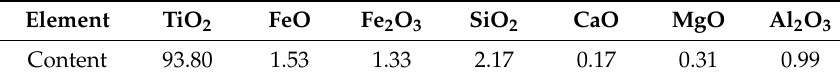
Figure 2. XRD pattern of rutile. Table 1. Multi-element analysis of pure rutile mineral (%).